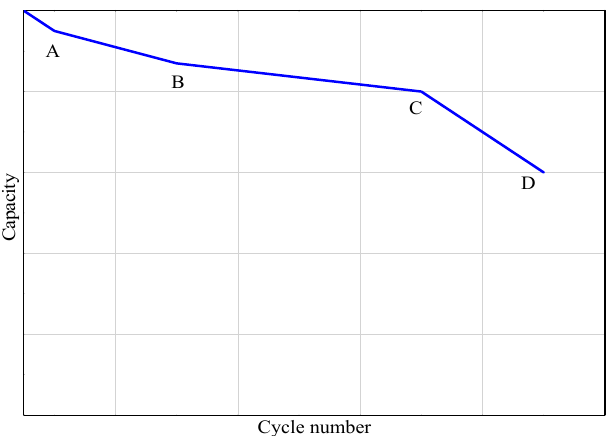
Figure 1. General capacity degradation of lithium-ion battery.